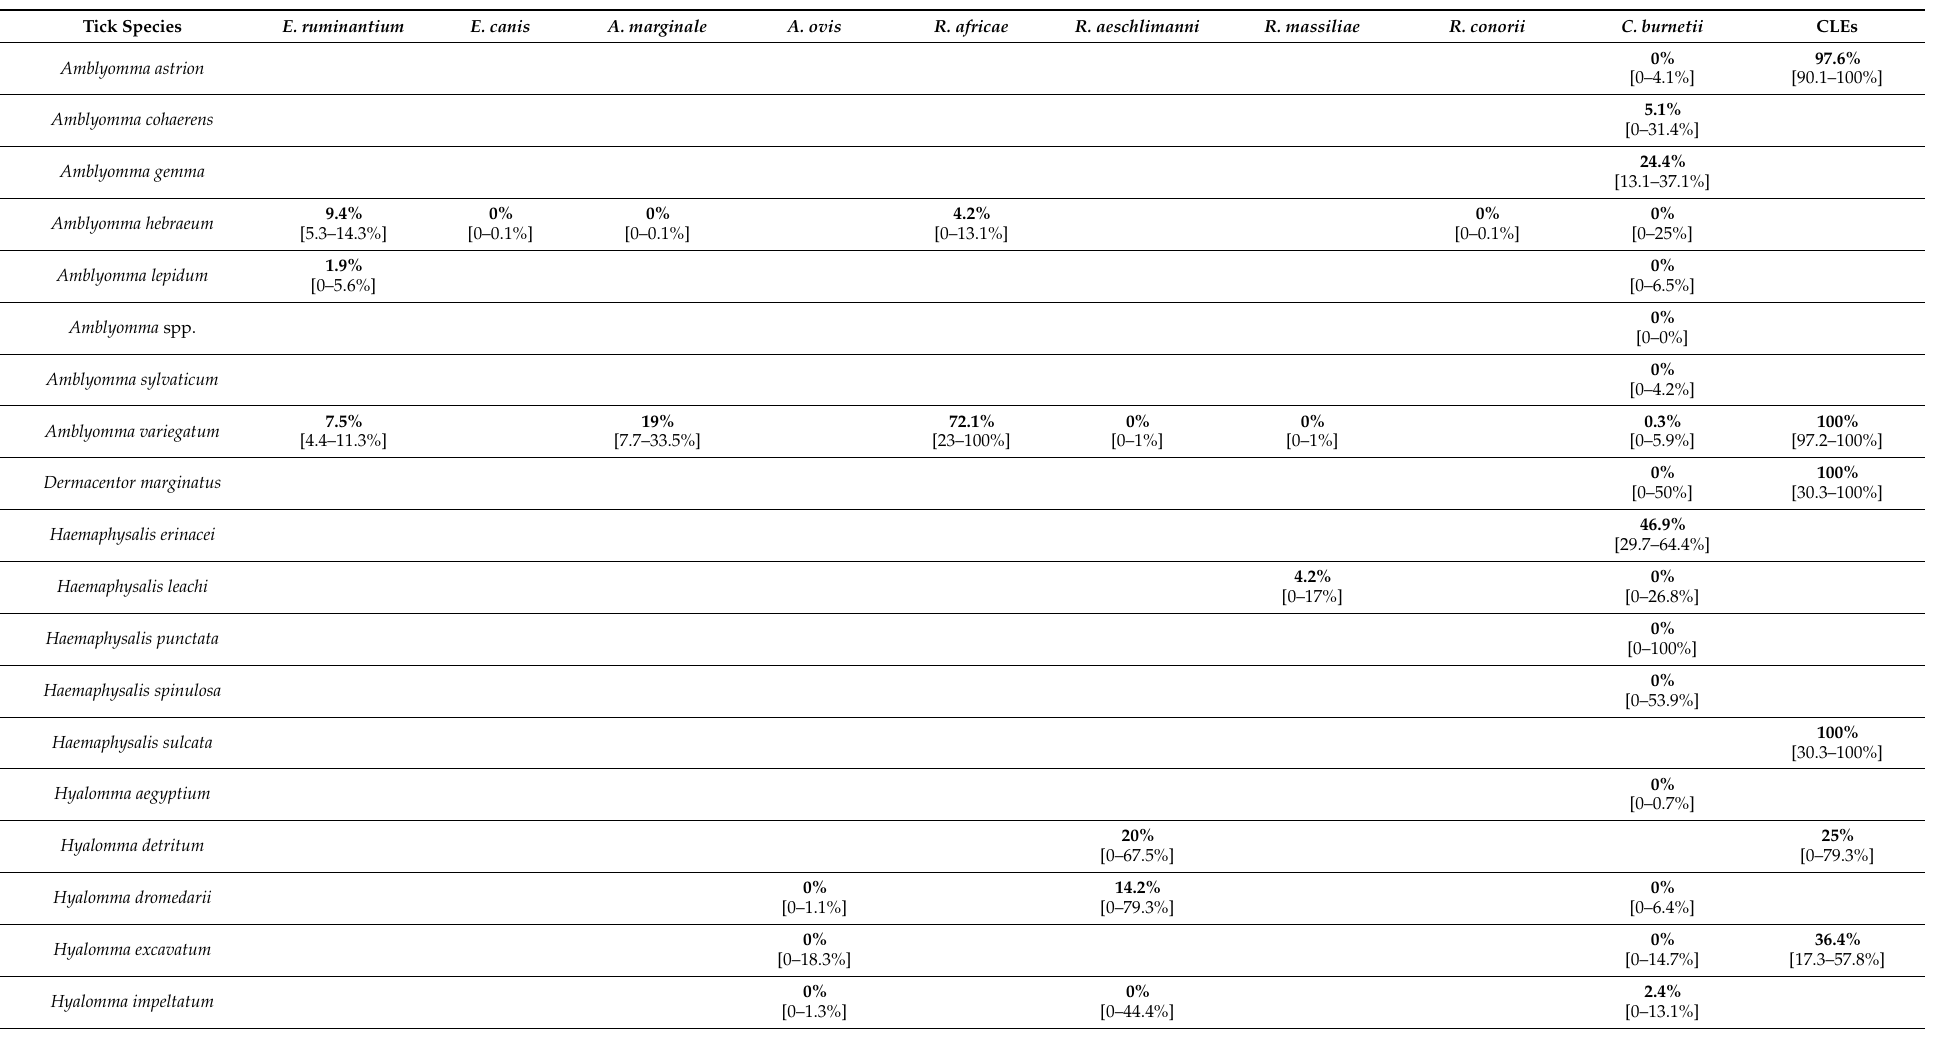
Table 5. Estimated prevalence in different tick